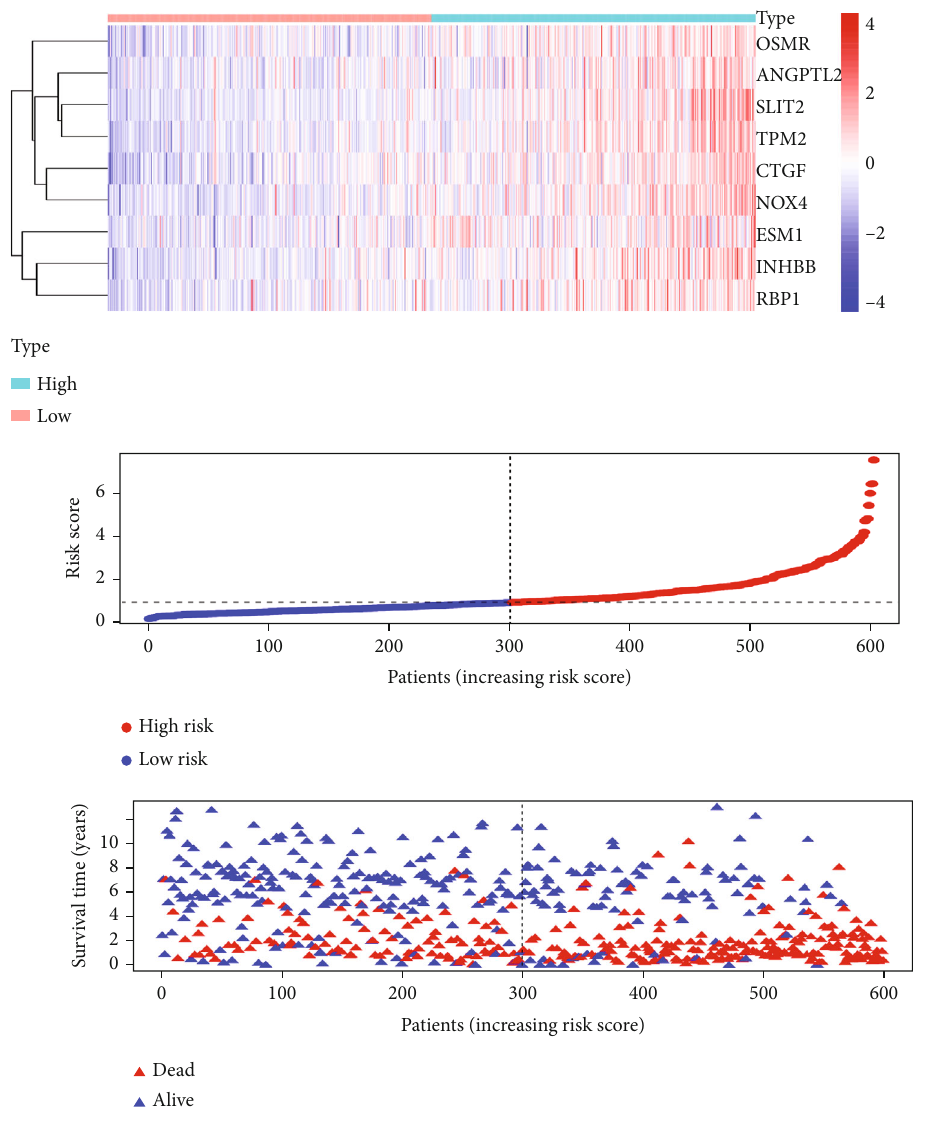
Figure 3: Heatmap, risk score distribution, and survival status of patients in the training cohort. Table 2: Univariate and multivariate Cox regression